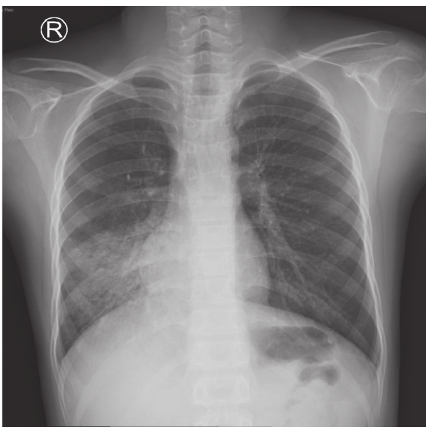
Figure 1: Chest X-ray documented right lower